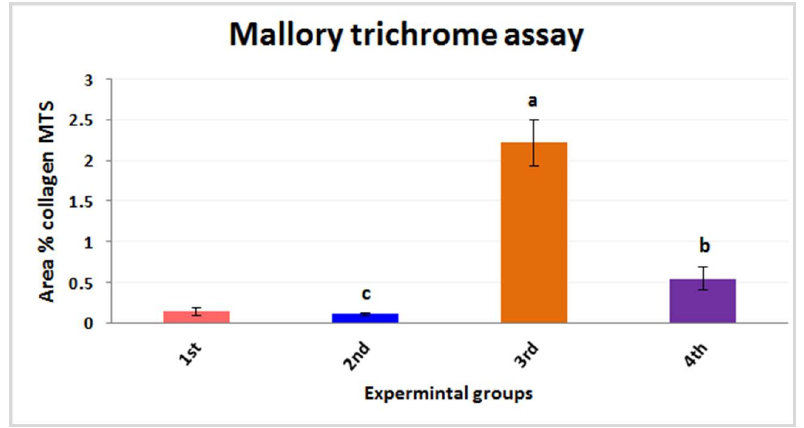
Figure 6. The quantification of fibrous histomorphometric observations for all experimental groups. The experimental groups are as follows; the first group is controlled mice (red column), the second group is PPE-treated mice (blue column), the third group is Fe 2 O 3 -NPs-exposed mice (orange column), and the fourth group is Fe 2 O 3 -NPs plus PPE-treated mice (purple column). Values are expressed as mean ± SE; they differ significantly at p < 0.05 by one-way ANOVA followed by Tukey’s multiple comparison post hoc test. The different letters (a, b, c) indicate different levels of significance ( p < 0.05), “a” indicates high significance ( p < 0.001), “b” indicates significance ( p < 0.05), and “c” indicates non-significance ( p > 0.05.)